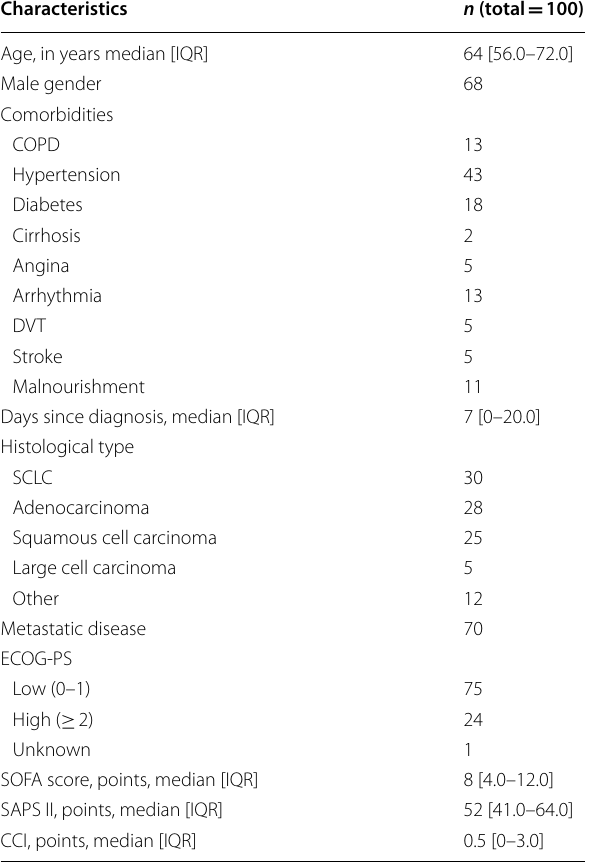
Table 1 Patients’ characteristics at ICU admission